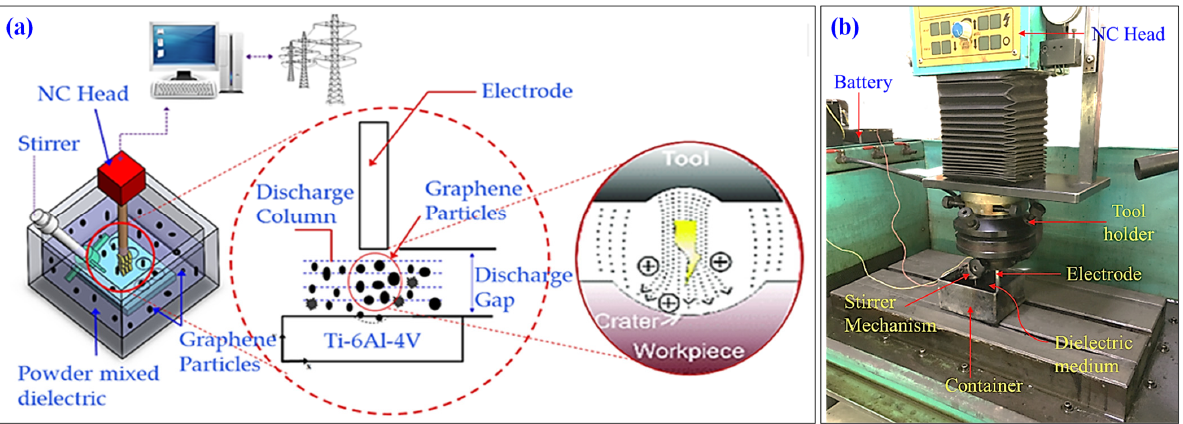
Figure 1. EDM setup: ( a ) schematic of EDM process under graphene mixed dielectric; ( b ) actual machining environment.